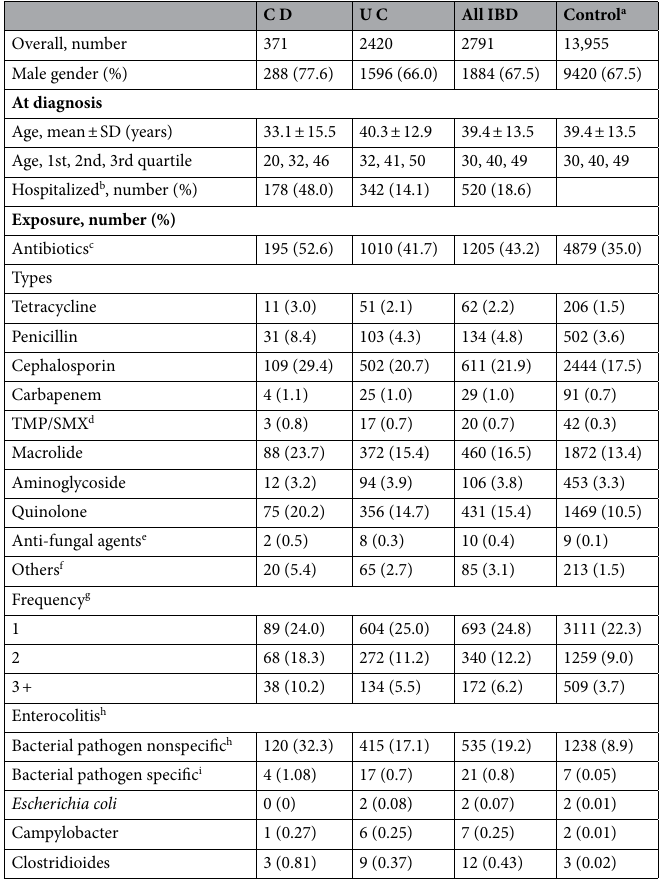
Table 1. Cohort demographic characteristics of newly diagnosed CD and UC, and time-, age-, and gender- matched non-IBD population included in this study. a Including time-, age-, and gender-matched non-IBD population for CD and UC. b Hospitalized at the month or next month with IBD diagnosis. c Prescribed betwwen 3 and 12 months before IBD diagnosis. d Trimethoprim/Sulfamethoxazole. e Amphotericin, Imidazole, and Triazole. f Metronidazole, Glycopeptide, Polymixin, Fosfomycin, Linezolid, Fidaxomicin, Rifaximin, and Anti-mycobacterials. g The number of types of antibiotics prescribed. h Between 3 and 12 months before diagnosis with bacterial pathogen nonspesific enterocolitis. i For 12 months before diagnosis with bacterial pathogen specific enterocolitis.